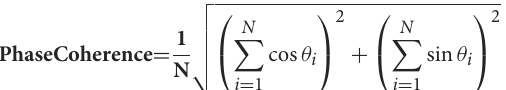
192 epochs were divided into 64 groups of three epochs. The phase of group i ( θ i , i = 1, 2,..., 64) was obtained from the complex responses averaged across the three epochs. Finally, phase coherence was calculated based on Equation 5